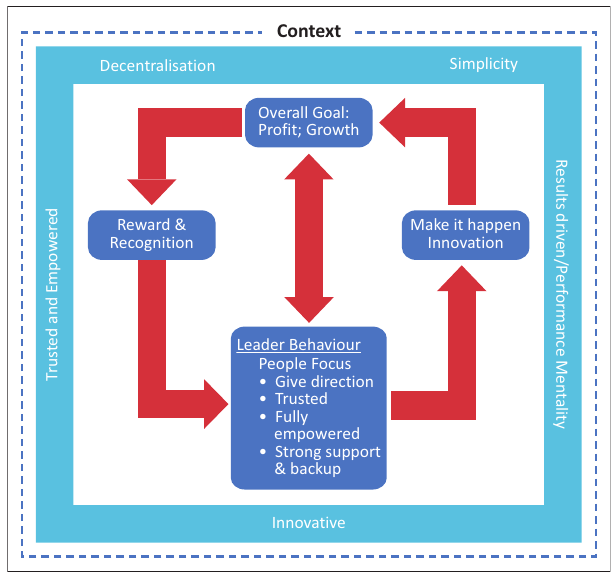
FIGURE 4: Influence of organisational context on leader